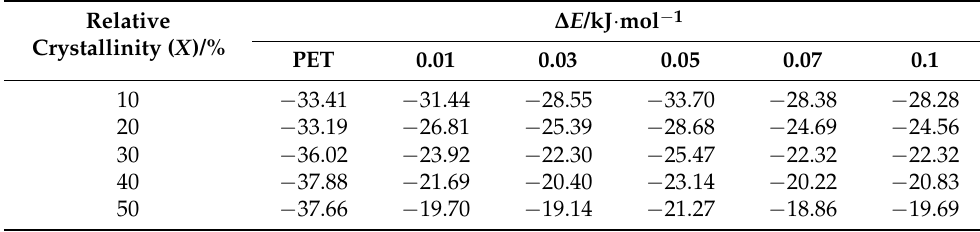
Table 6. Non-isothermal crystallization activation energy of PET by Friedman